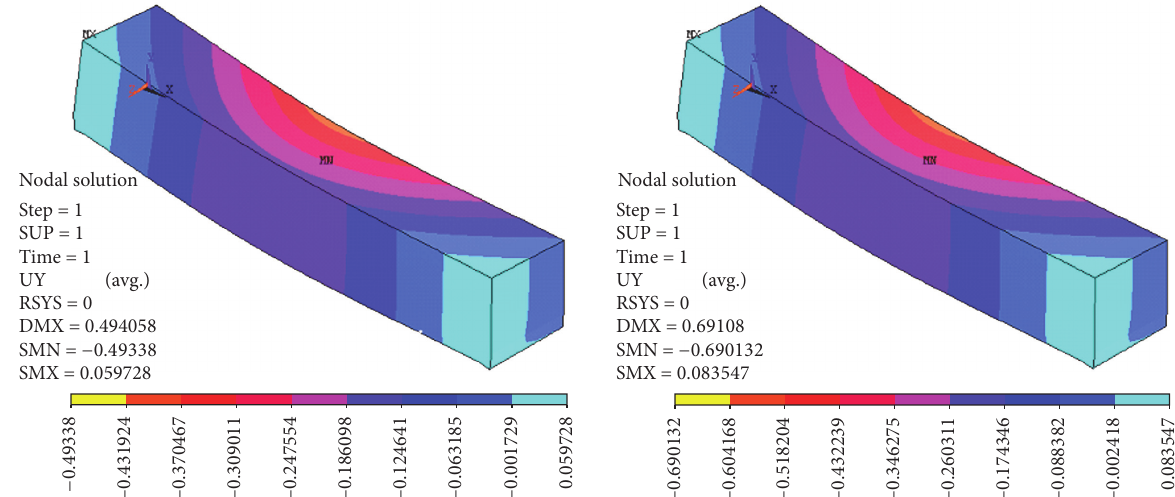
Figure 8: Flexural behaviour of RCC beam in CC and GPC.